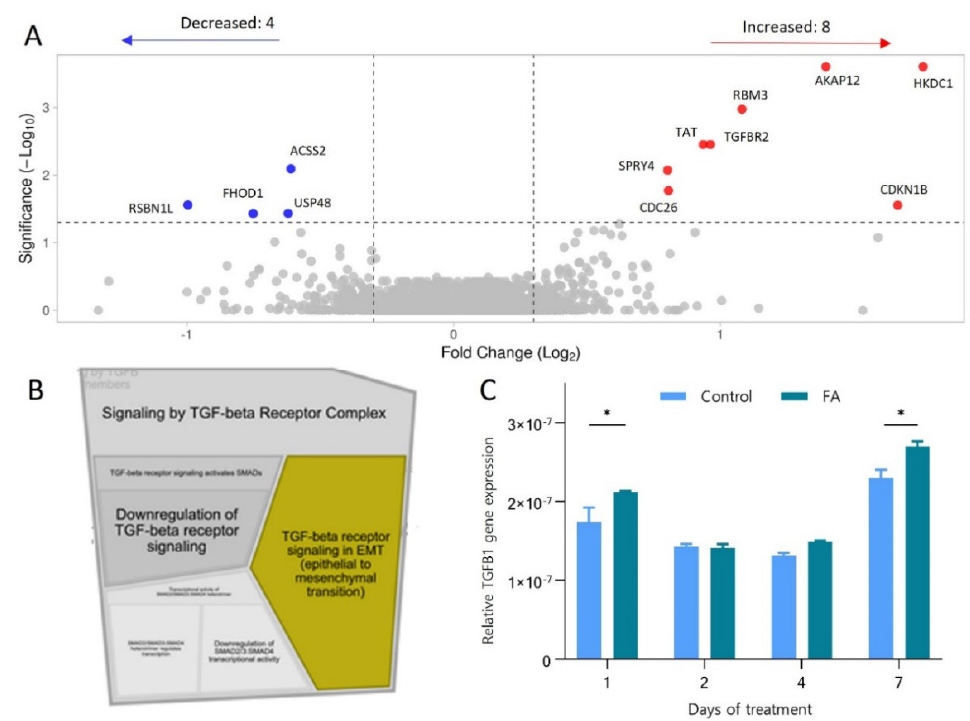
Figure 5. Proteomics reveals increased TGF-B signalling and epithelial to mesenchymal transition. FA-spheroids treated with 45 µ M palmitic acid and 65 µ M oleic acid, Control-spheroids in standard growth media. ( A ) Volcano plot depicting proteins regulated in FA-treated spheroids (7 days) compared to the Control. The log2 change of FA vs. Control is plotted against − log10 q -value calculated using PolyStest. The significance threshold (dotted lines) was set to q < 0.05 and a fold change of ± 1.2. Red dots-upregulated proteins, blue dots-downregulated proteins. ( B ) Fragment of the resulting pathways enrichment graph obtained using Reactome Pathway Database software [41]. Yellow indicates a statistically significant enriched category. ( C ) Relative TGF-B1 gene expression was measured by qPCR after one, two, four and seven days of treatment. * statistically significant difference according to Student’s t -test and Holm–Sidak post hoc test, p < 0.05, n = 3. Error bars show the standard error of the